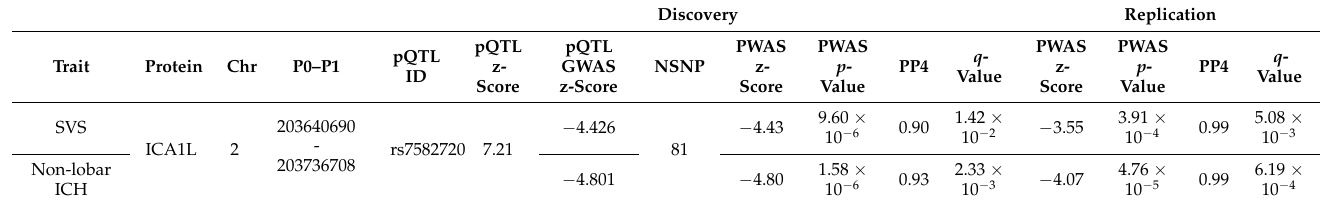
Table 1. PWAS results for the stringent criteria. Significant PWAS associations using the stringent criteria in the discovery and replication. P0–P1: initial-final position for the analysed protein; pQTL ID: ID for the pQTL strongly associated with ICA1L; pQTL z-score: z-score for the pQTL strongly associated with ICA1L; pQTL z-score: z-score in the correspondent GWAS for the best pQTL; NSNP: number of SNPs in the locus; TWAS z-score: z-score for the PWAS association; PWAS p -value: p -value for the PWAS association; PP4: posterior probability 4 in the COLOC analysis; q -value: FDR-adjusted PWAS p -value. Discovery Replication